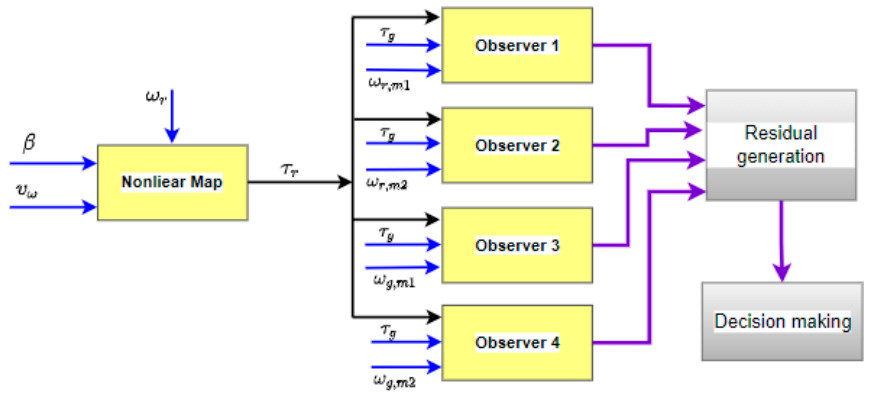
Figure 4. FDI architecture for drive